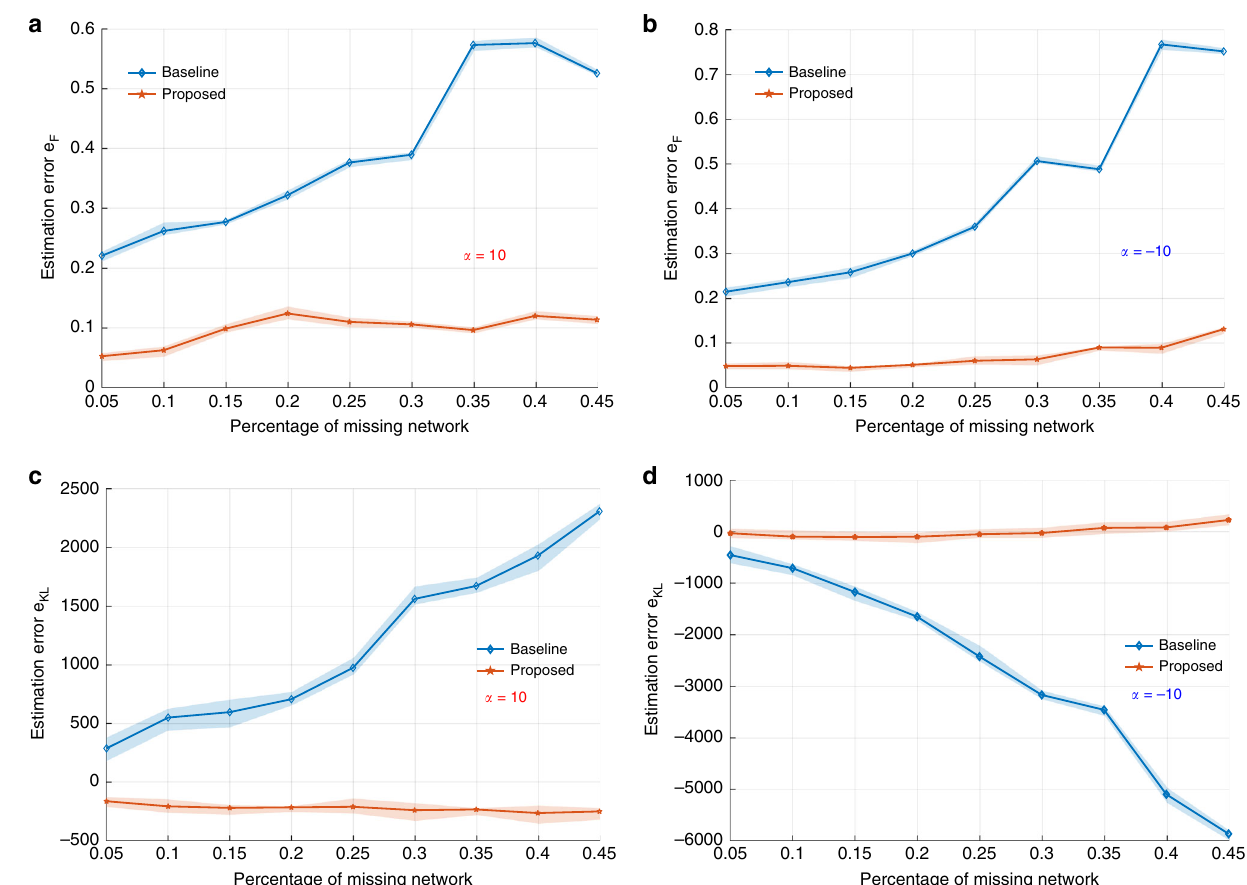
Fig. 2 Quantifying the capability of inferring synthetic networks under varying attack strategies. a , b Estimation error e F as a function of missing network under hub-prioritized ( a ) and boundary-prioritized ( b ) intervention ( α = 10 or − 10). c , d KL divergence comparison of the true linking probability distribution and the recovered ones by baseline and proposed frameworks with the presence of hub-prioritized ( c )/boundary-prioritized ( d )